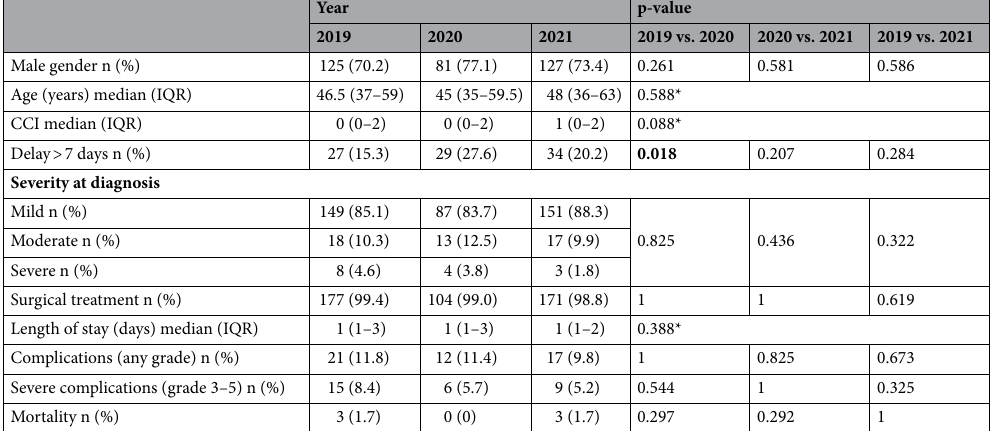
Table 5. Perianal abscess patients characteristics. CCI Charlson Comorbidity Index. *Non-significant p-value in Kruskal–Wallis test, therefore no multiple comparations were